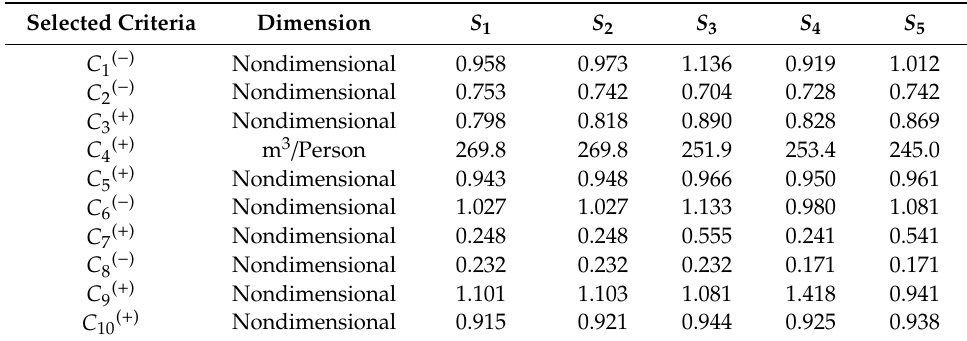
Table7. EvaluationmatrixofthewaterstrategieswithrespecttothecriteriafortheKashafroudwatershed. Selected Table 7. Evaluation matrix of the water strategies with respect to the criteria for the Kashafroud watershed.